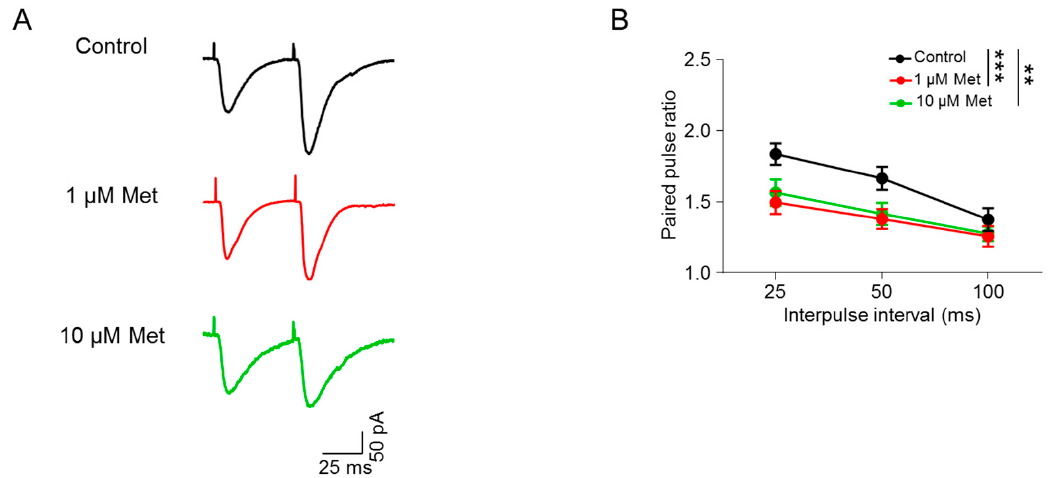
Figure 3. Met increases glutamate release in CA1 hippocampal pyramidal neurons. ( A ) Representative traces of pair-pulse stimulation. Scale bar = 25 ms, 50 pA. ( B ) Paired-pulse responses (PPRs) plotted against inter-stimulate intervals. n = 9–11 neurons from three mice per group. Drug treatment: control versus 1 µ M Met, F(1,51) = 15.54, p = 0.0002; control versus 10 µ M Met, F(1,57) = 10.72, p = 0.0018; 1 µ M Met versus 10 µ M Met, F(1,54) = 0.4391, p = 0.5104; two-way ANOVA followed by Bonferroni’s post hoc test. Data are presented as mean ± SEM, ** p < 0.01, *** p <